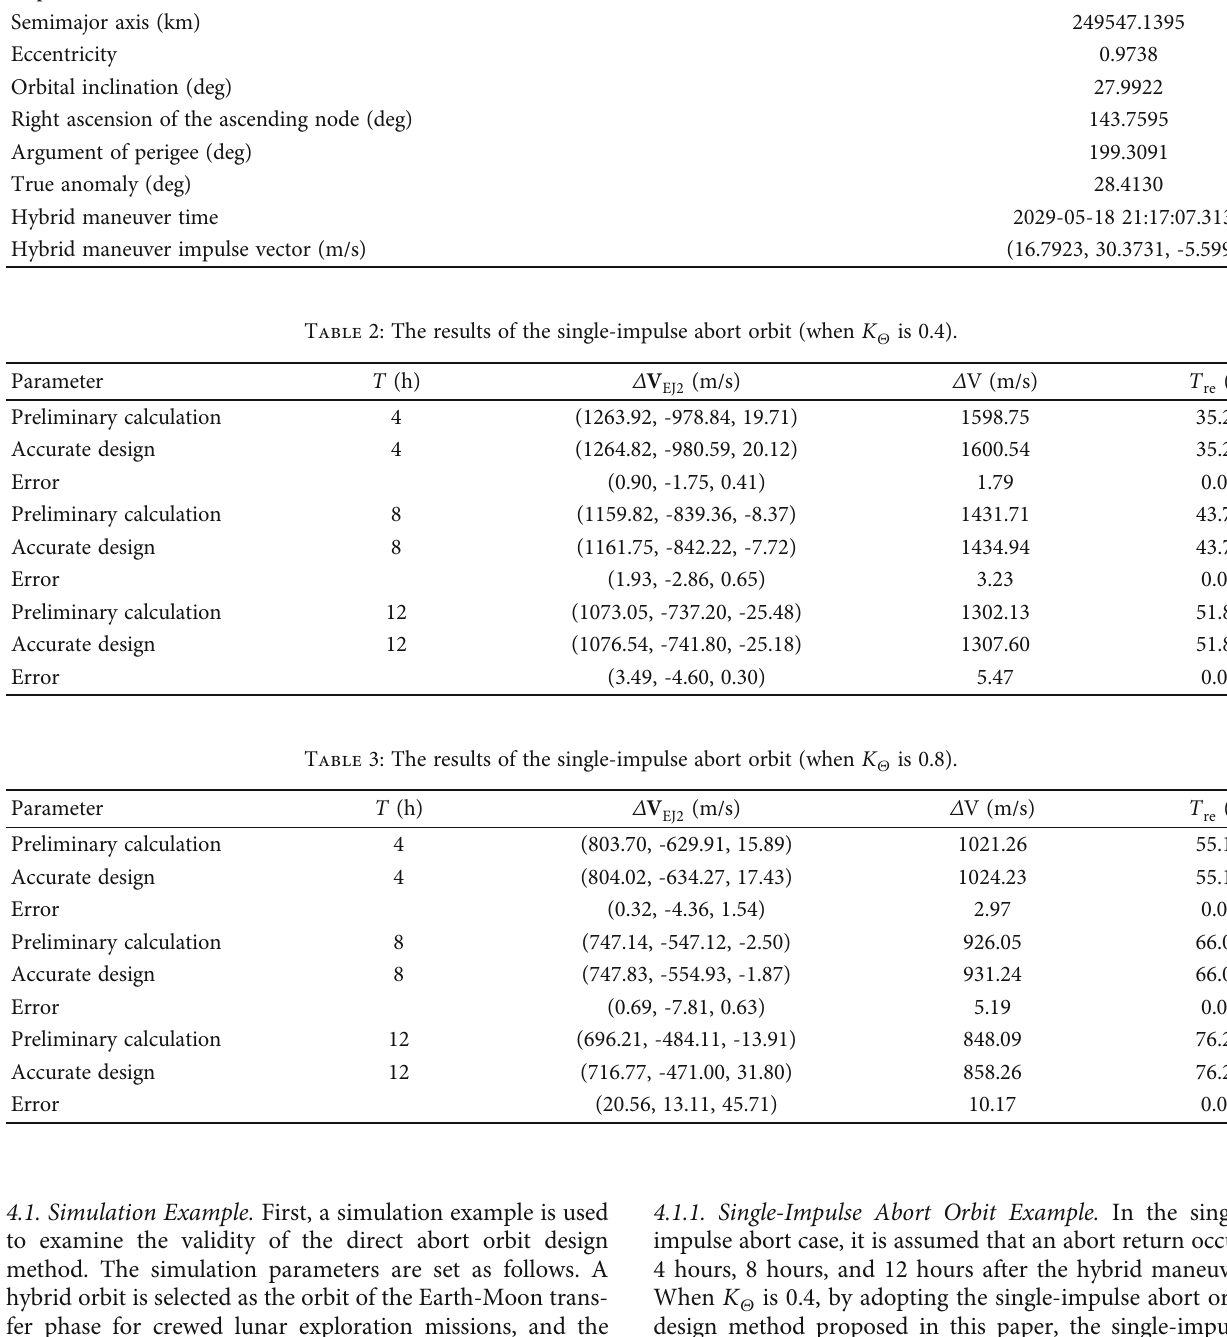
Table 1: Orbital parameters of the hybrid orbit.